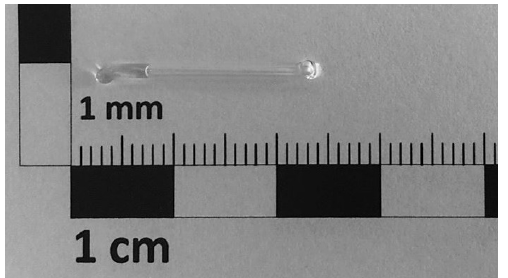
Figure 3. Glass container filled with 2 µL of water for assembly inside the